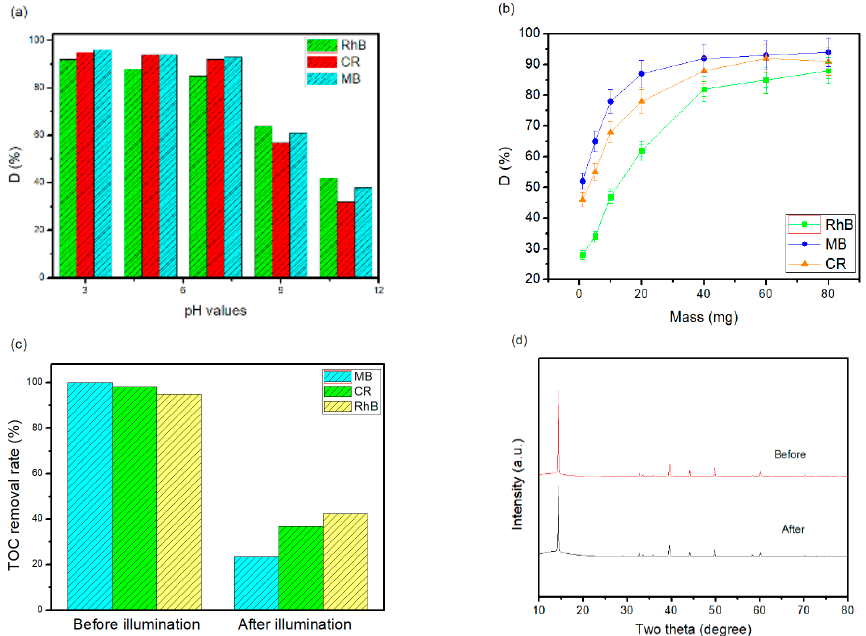
Figure 7. ( a ) The e ff ect of initial pH, ( b ) the e ff ect of dosage on the degradation under visible light (500 mL, 20 ppm aqueous solution), ( c ) the TOC amount of organic dye before and after irradiation, and ( d ) XRD patterns of the fresh and used nanohybrid photocatalysts.